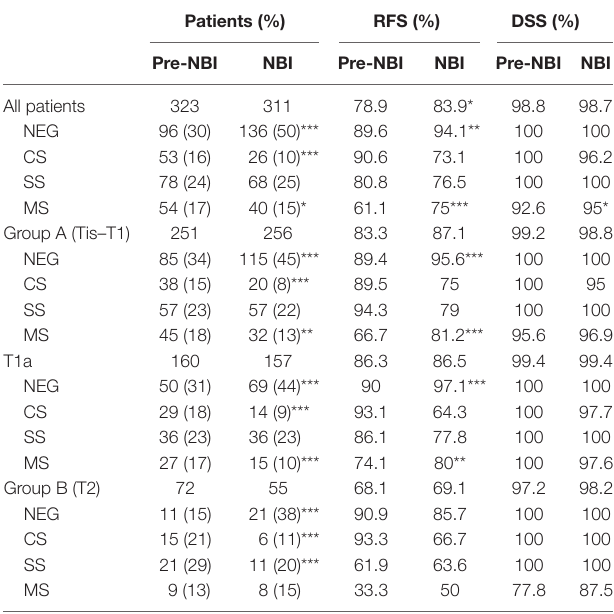
Table 5 | Impact of narrow band imaging (NBI) on 5-year recurrence-free survival (RFS) and disease-specific survival (DSS) for the entire cohort of patients, for Groups A and B, and for pT1a